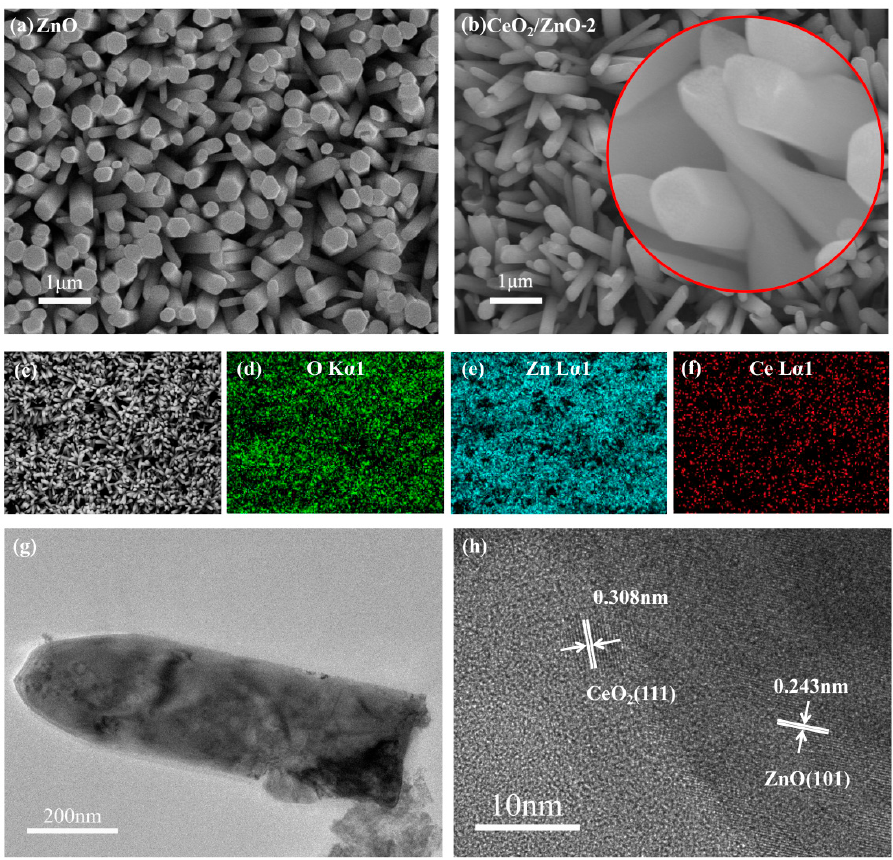
Figure 3. FESEM images of ZnO ( a ) and CeO 2 /ZnO-2 ( b ). ( c – f ) EDS images of CeO 2 /ZnO-2; TEM ( g ) and HRTEM ( h ) of CeO 2 /ZnO-2.